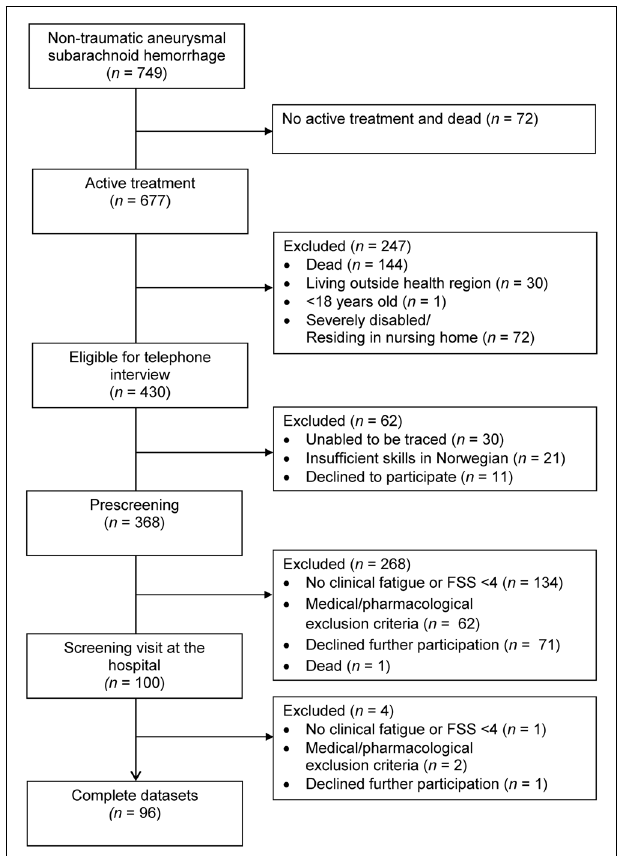
FIGURE 1 | Flow chart of patient